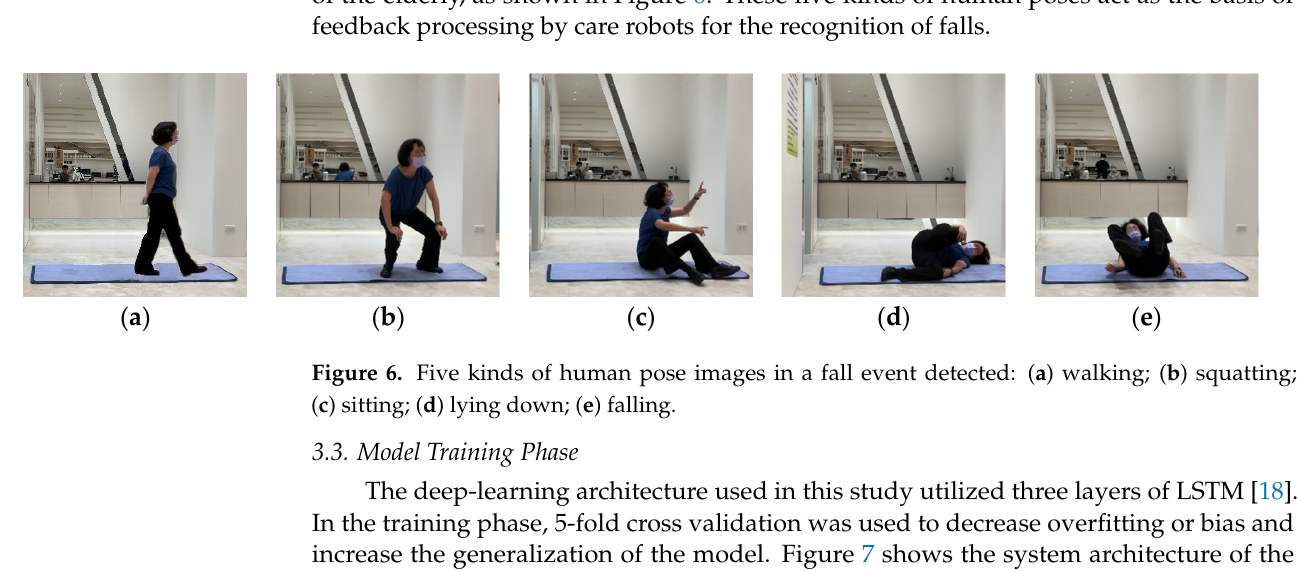
( c ) sitting; ( d ) lying down; ( e ) falling.